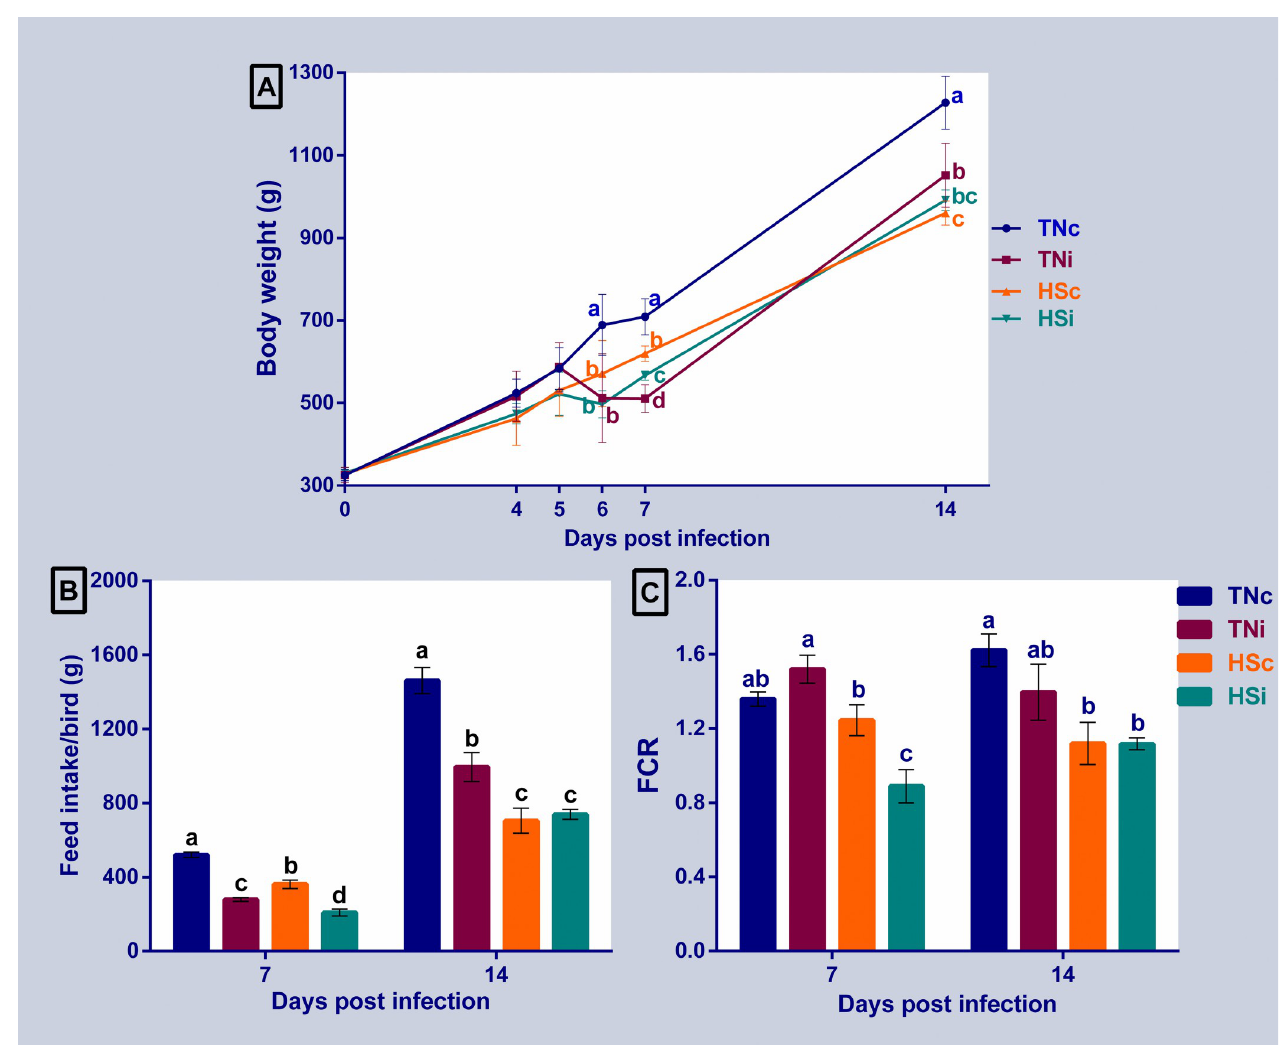
Fig 2. Chickens’ growth, feed intake, and FCR. The average body weight at 4, 5, 6, 7, and 14 dpi (A), feed intake at 7 and 14 dpi (B), and feed conversion ratio (FCR) at 7 and 14 dpi (C) of chickens infected with E . maxima and their uninfected controls that are raised in a thermoneutral or heat stress environment: TNc = thermoneutral control, TNi = thermoneutral infected, HSc = heat stress control, HSi = heat stress infected. Significant differences (p < 0.05) were depicted by different letters. The error bars represent the SEM.